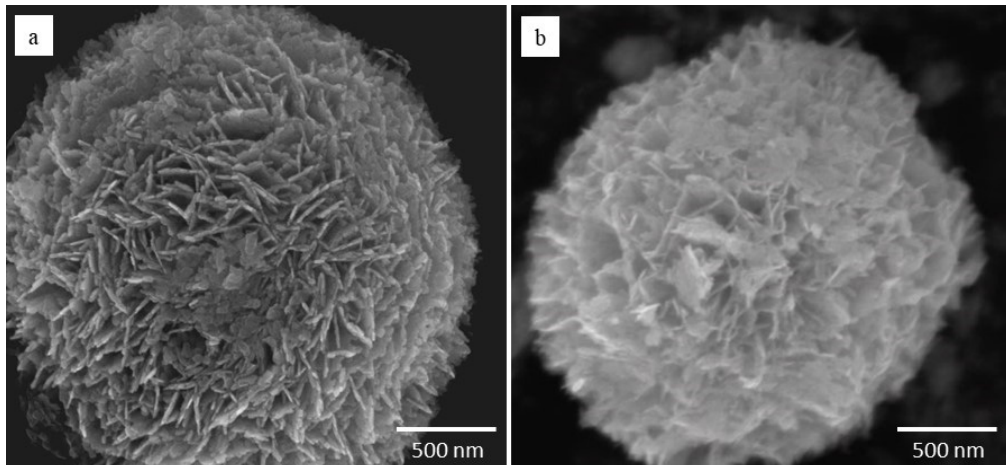
Figure 2. SEM images of the as synthesized ( a ) BiOCl sample by co-precipitation, and ( b ) BiOI sample by microwave